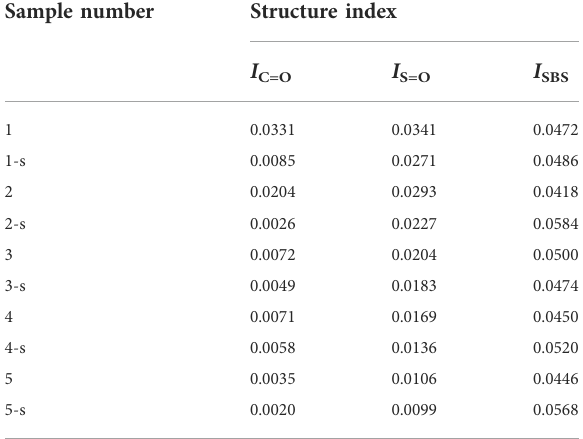
TABLE 6 Group structure index the samples under investigation (cf. Table 3 for